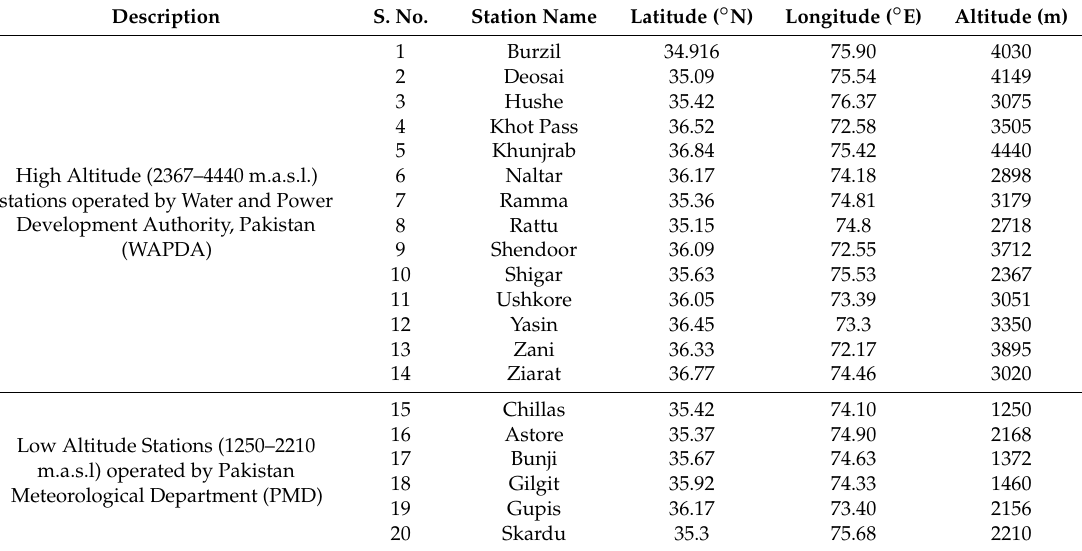
Table 1. Geographical attributes of the precipitation gauge